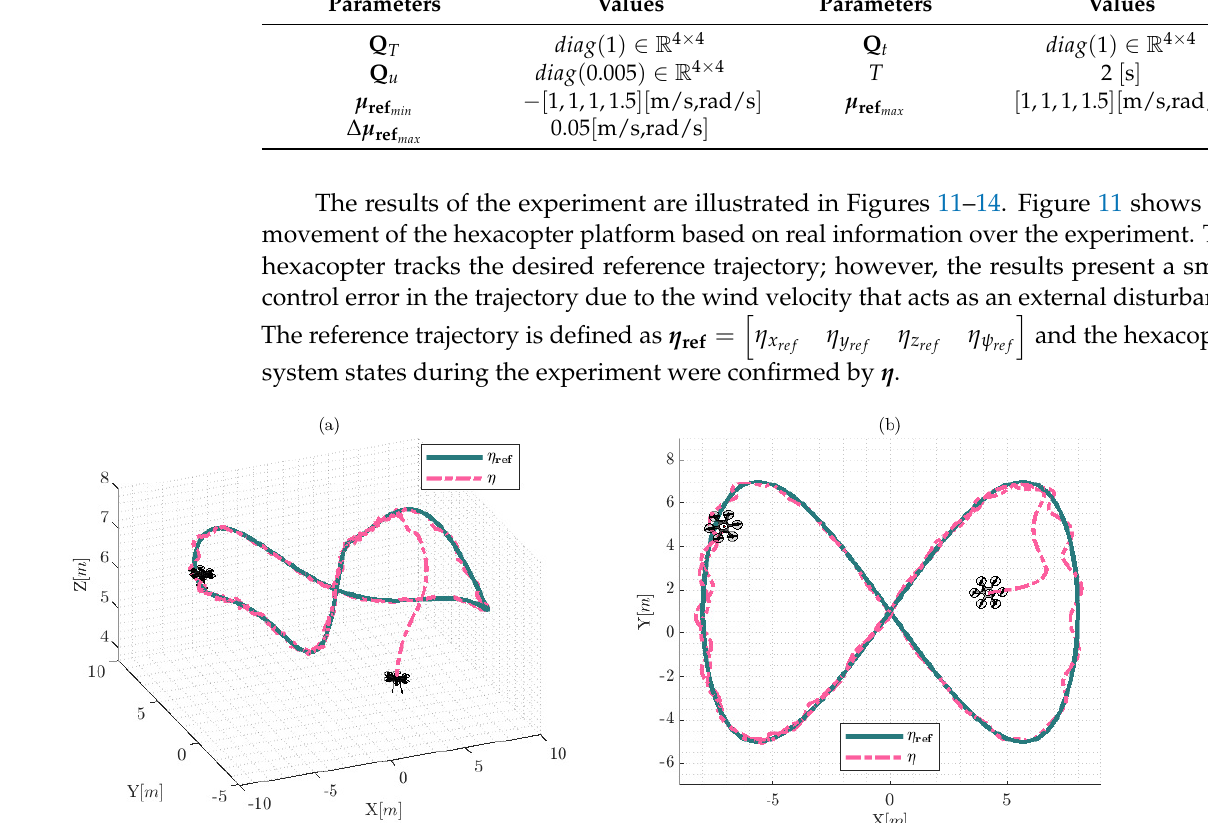
(cid:8) (cid:9) I x , I y , I z ; and ( b ) shows